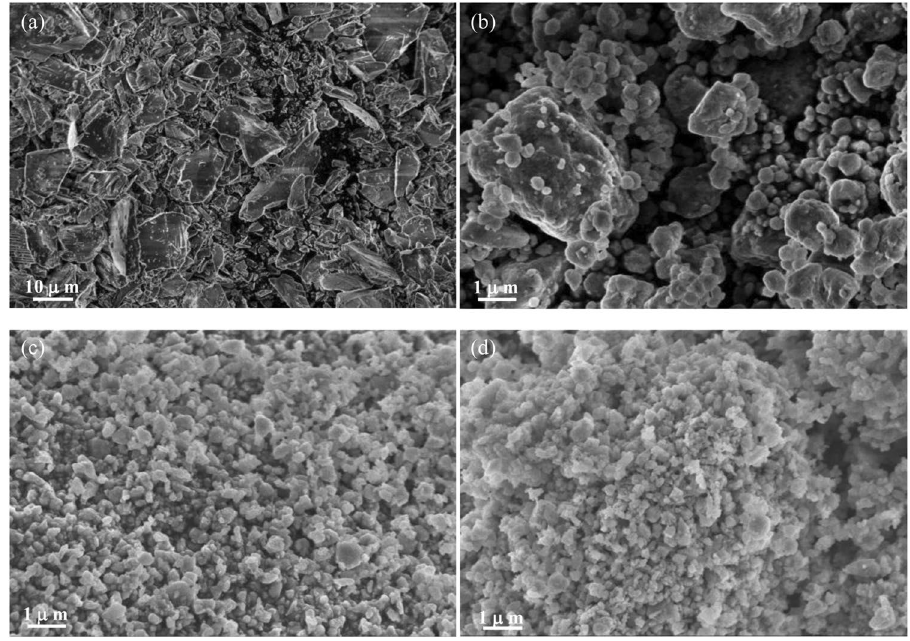
Figure 2. SEM micrographs of the ( a ) Si P , ( b ) SCV H , ( c ) SCV H + W , and ( d ) C-SCV H + W ,